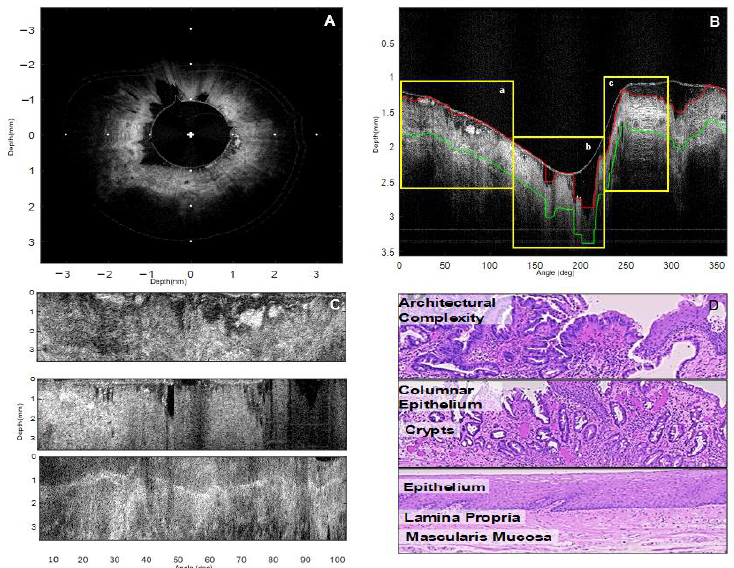
Figure 15. ( A ) In vivo OCT image of the human esophagus in Cartesian coordinates. ( B ) Same image in polar coordinates with the red and green lines indicating the top and bottom borders of the automatically segmented epithelial region (segmentation depth ~0.55 mm). The yellow boxes indicate annotated dysplastic (a), BE (b) and normal (c) regions. ( C ) Zoomed regions corresponding (from top to bottom) to the dysplastic, BE and normal annotated areas respectively. ( D ) Histopathologic sections (from unrelated samples) that illustrate the microstructural and nuclear changes associated with (from top to bottom) dysplastic, BE and normal esophageal tissue [182].